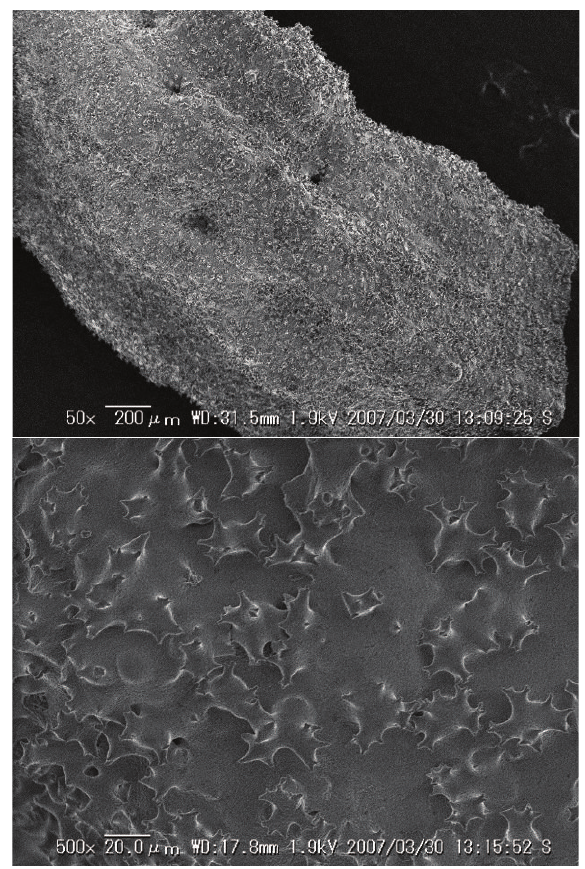
Figure 27: SEM image of axis surface of Corallium konojoi ; OCA- Cn20060111-047.